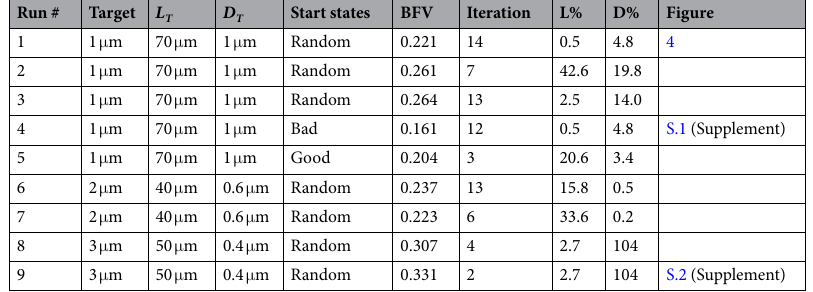
Table 1. Results of optimisation for 9 experiments over three different targets. Each run is identified by a run number, target length, and diameter. The table shows the starting state (random, bad, or good), best found value (BFV) of the objective function, the iteration this was achieved, and the corresponding deviations from target length and